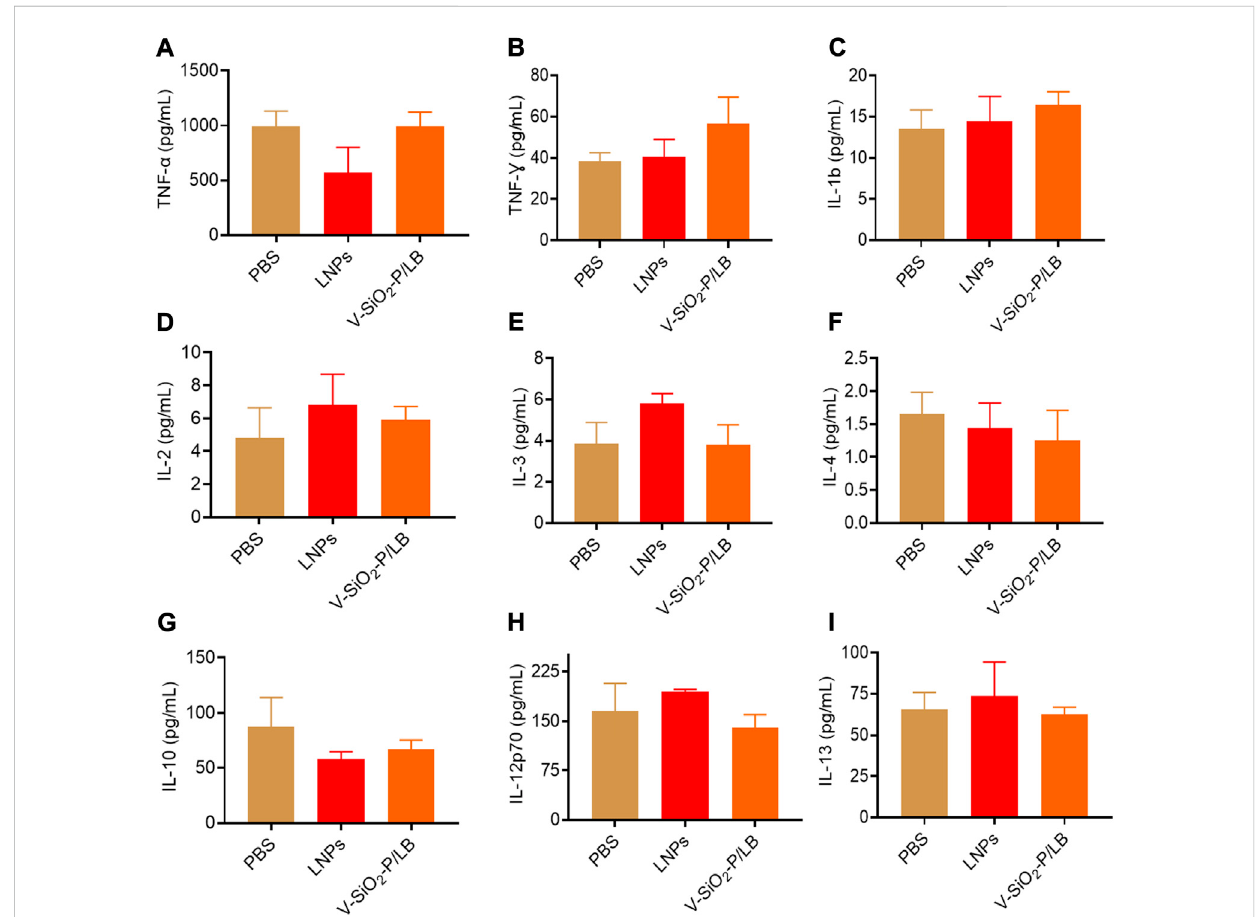
FIGURE 6 The cytokines and chemokines of V-SiO 2 -P/LB nanoparticles in vivo . The levels of the cytokines and chemokines (A) TNF- α , (B) TNF- γ , (C) IL-1b, (D) IL-2, (E) IL-3, (F) IL-4, (G) IL-10, (H) IL-12p70, and (I) IL-13 determined by a multiplex protein array kit.